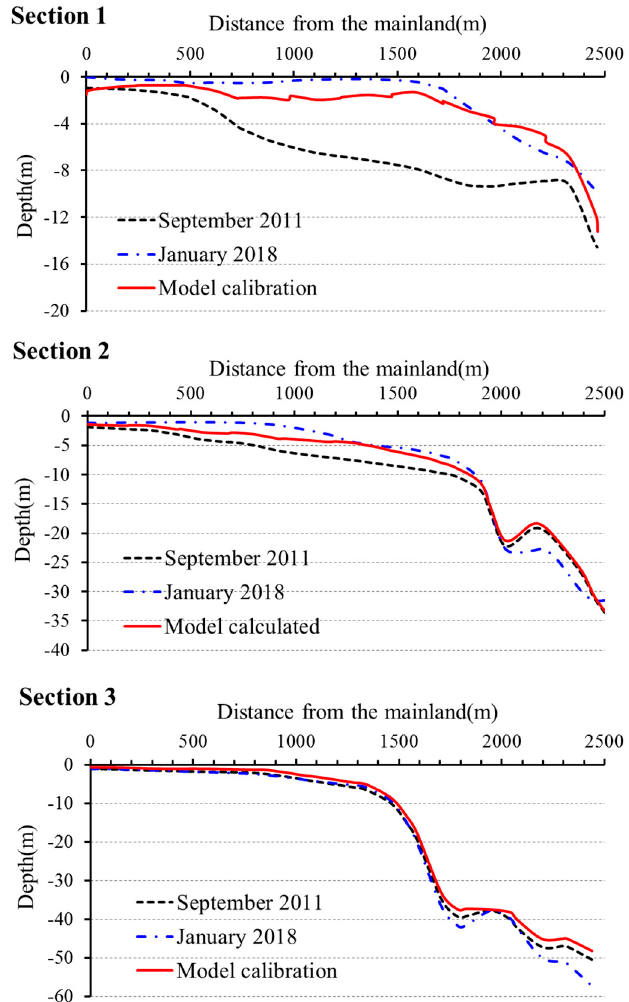
Figure 7. Comparison of calculated and measured seabed deformation at different sections.